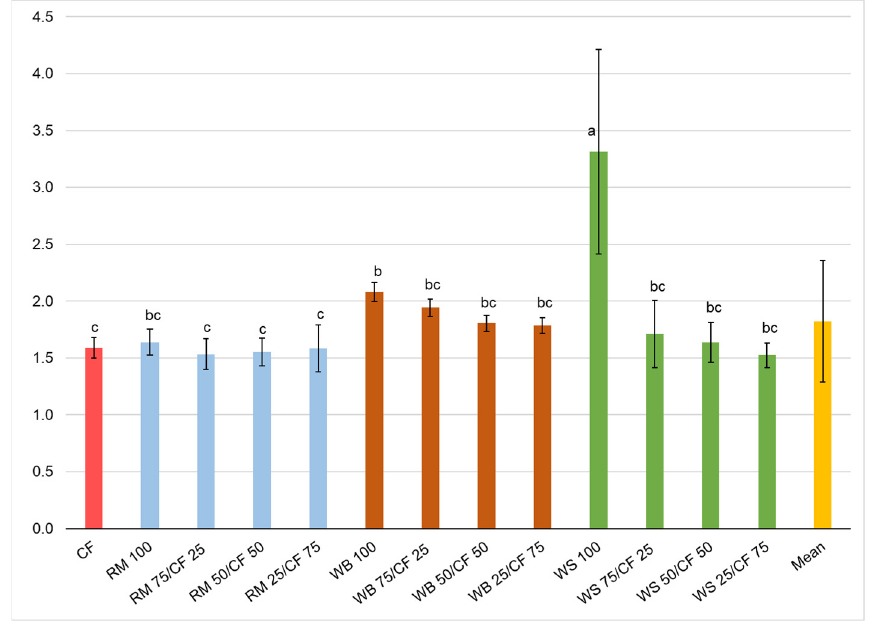
Figure 4. Mealworm feed conversion ratio (FCR). a,b,c…—letters indicate that values are statisti ‐ cally different (Tukey’s test at p < 0.05). different (Tukey’s test at p <